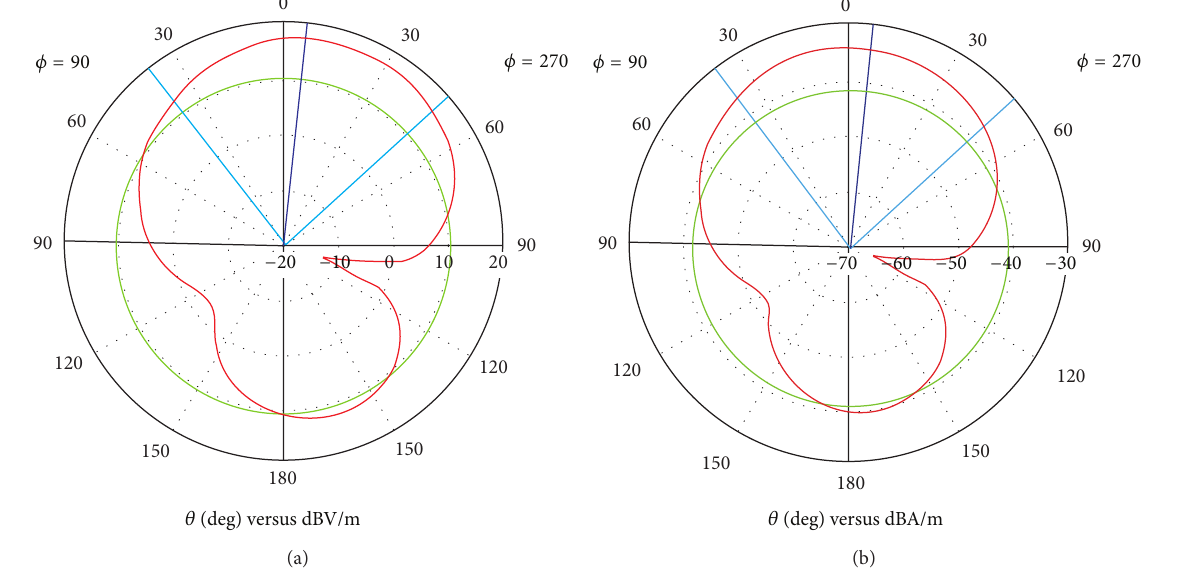
Figure 6: Second stage of proposed antenna. (a) E -field and (b) H -field.